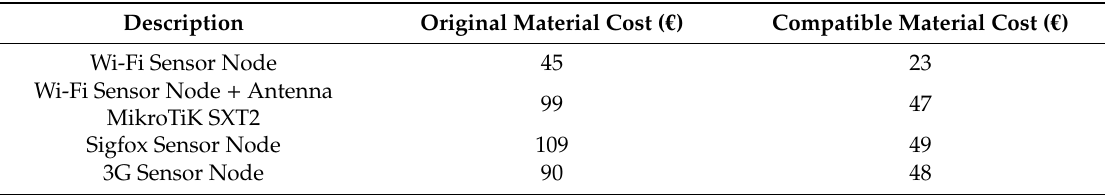
Table 3. The cost of the sensor nodes.